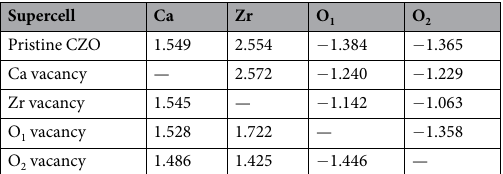
Table 3. Estimated effective Bader charges, e , of Ca, Zr and O atoms in pristine CaZrO 3 and supercells 0 containing isolated V X